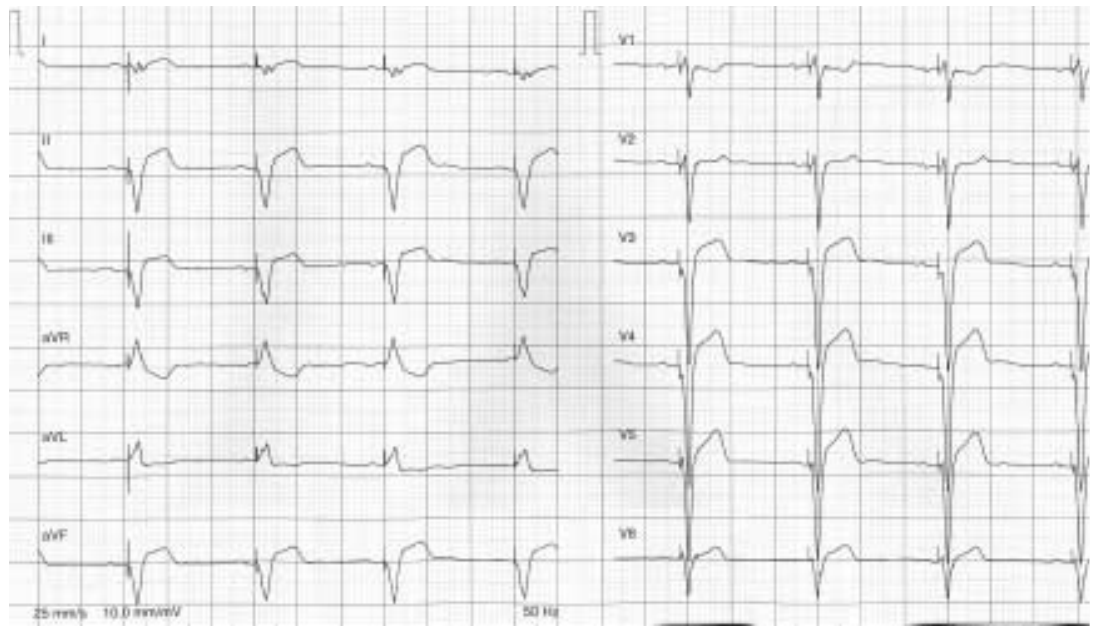
Figure 2 B: Twelve-lead electrocardiogram of the same patient after cardiac resyn- chronization showing a smaller QRS (180 ms) and short AV delay (170 ms) with biventricular pacing.